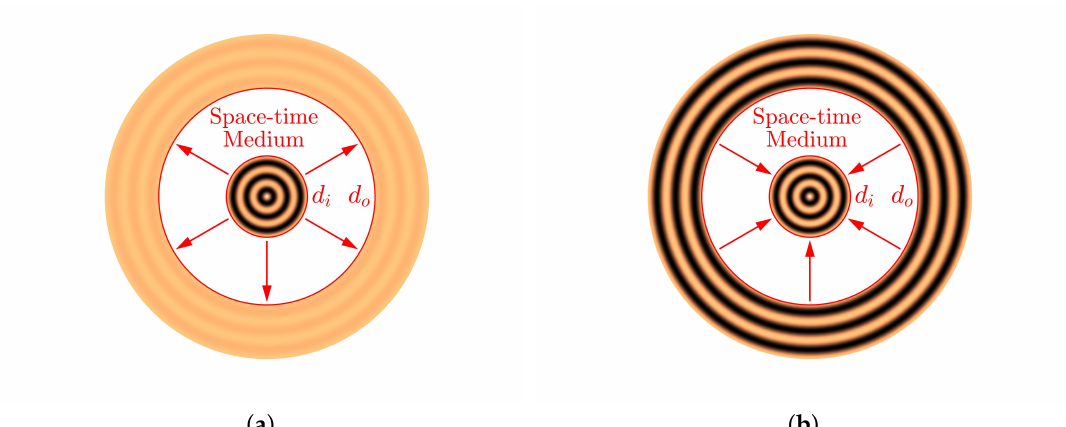
Figure 1. Graphical representation of the one-way effect. ( a ) Waves are allowed to propagate from the inner to the outer shells d i and d o of the spatiotemporally modulated radial sonic crystal (RSC) (white region in the drawing) when the modulation travels from the outer to the inner shell. ( b ) Vice-versa, waves are not allowed to reach the outer shell if the modulation travels from the inner to the outer